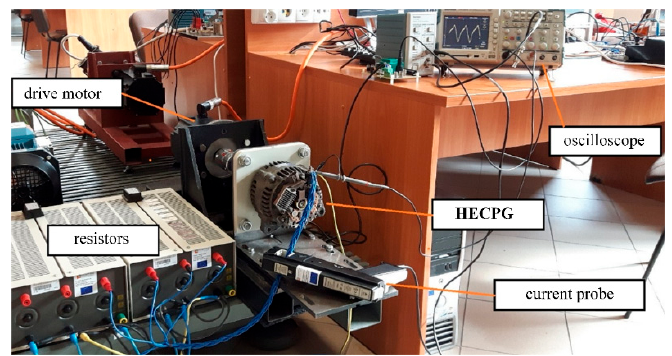
Figure 18. Test stand with HECPM [57].